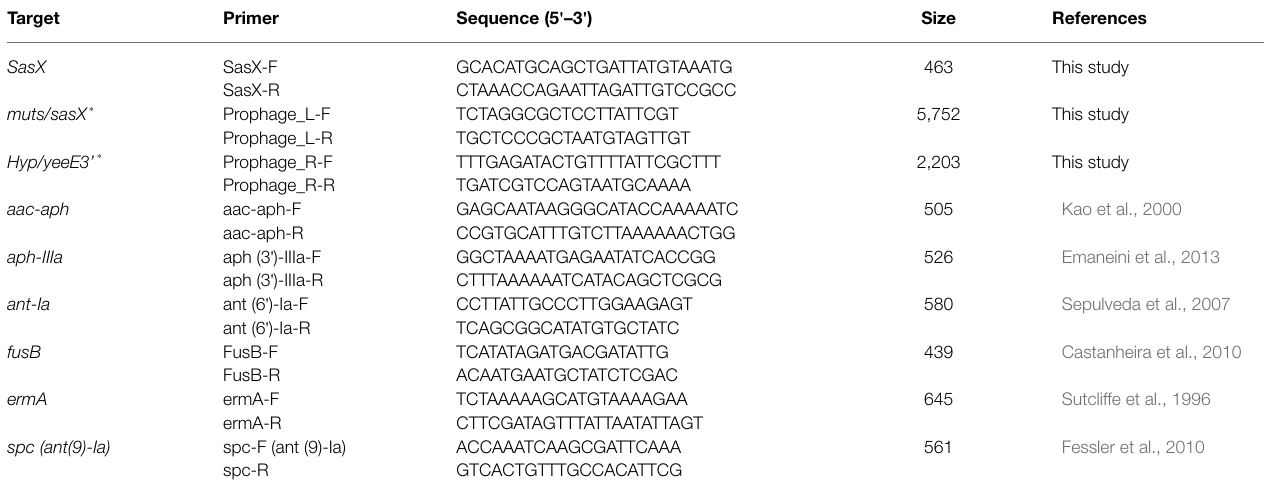
TABLE 1 | PCR primer sets used in this study.